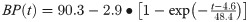
Time courses of mean BP response to a one step odor stimulation by inhaling sweet marjoram essential oil.Panel A: Protocol 1; The averaged regression line was BP(t)=90.3−2.9•[1−exp(−t−4.648.4)]. Panel B: Protocol 2; The averaged regression line was BP(t)=84.4−4.5•[1−exp(−t−12.758.8)]. Solid lines, means; dashed lines, means±SE.